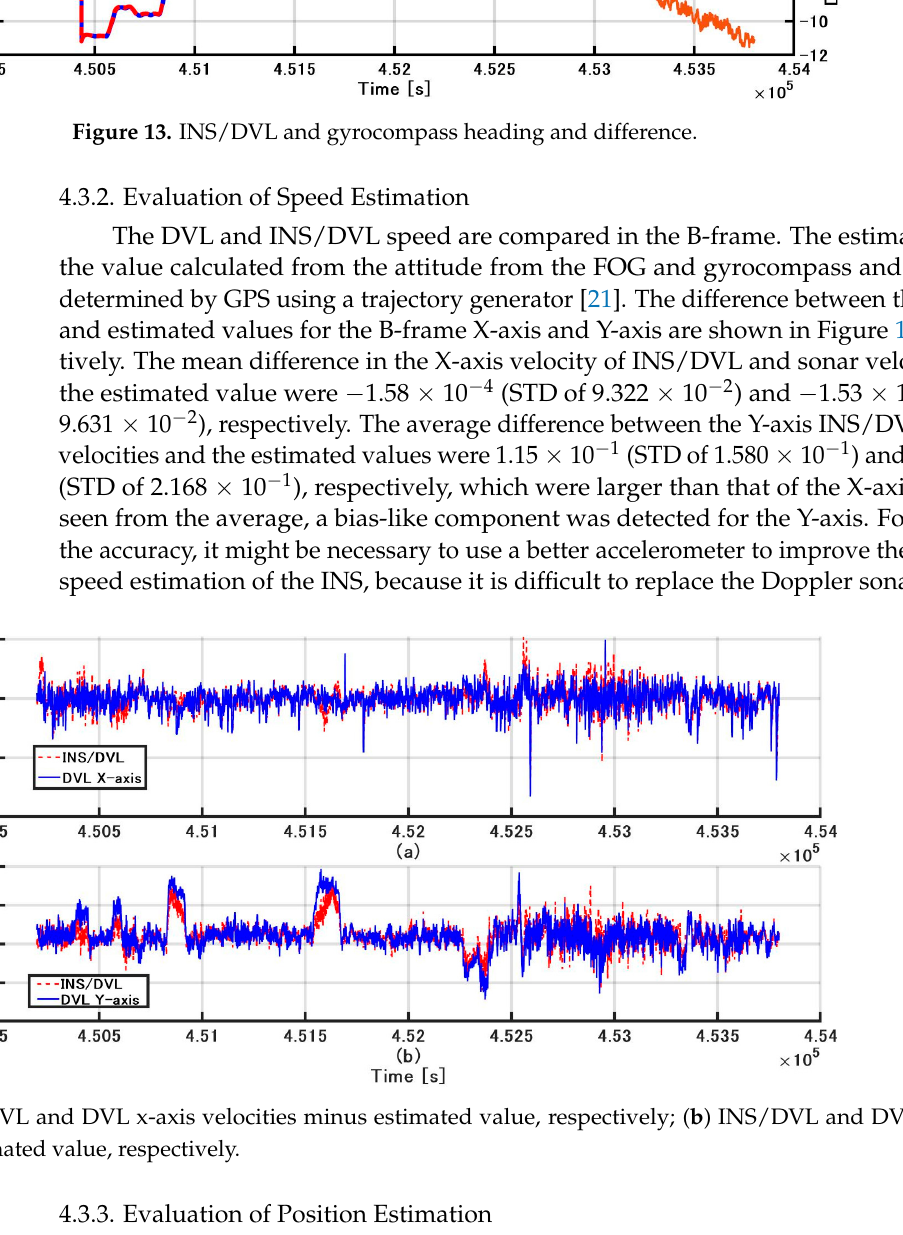
Figure 13. INS/DVL and gyrocompass heading and difference.